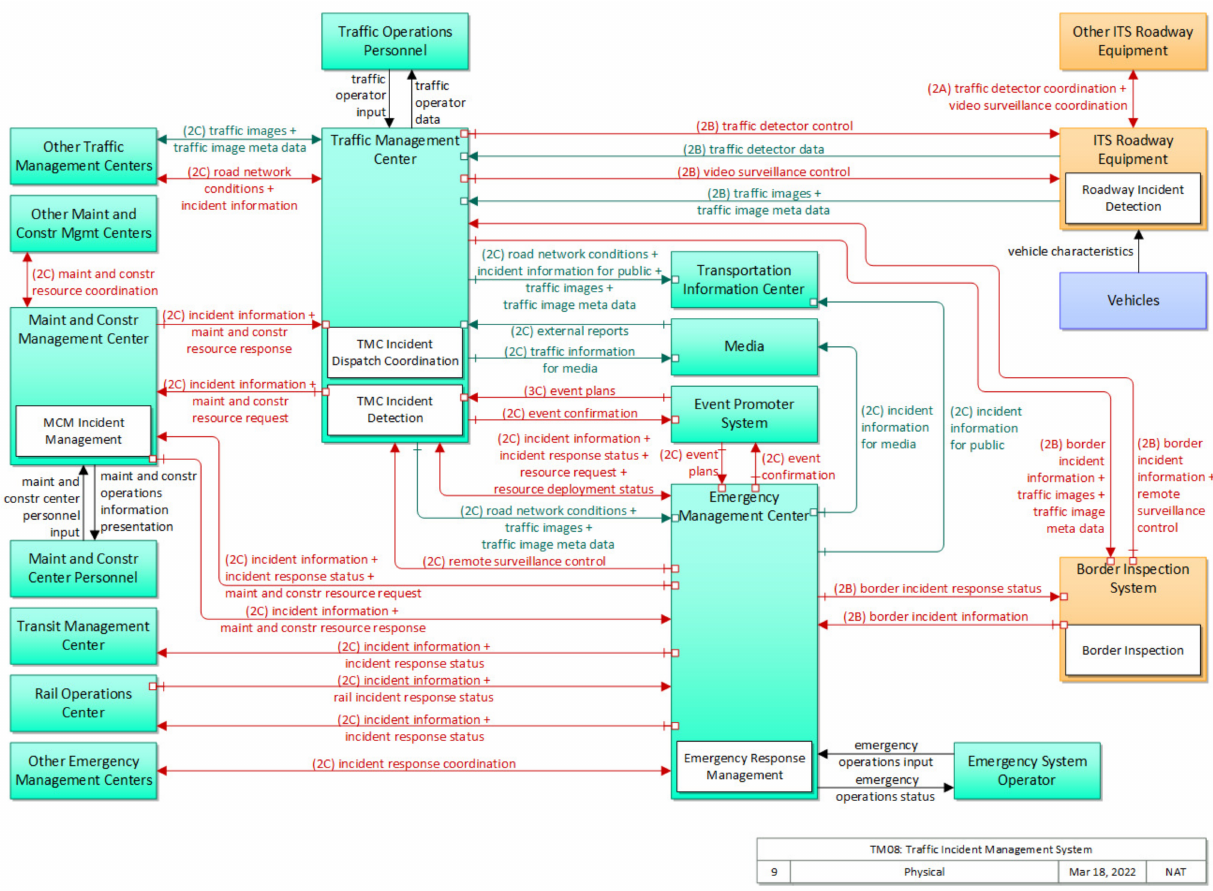
Figure 1. Traffic incident management system service pack: physical architecture view